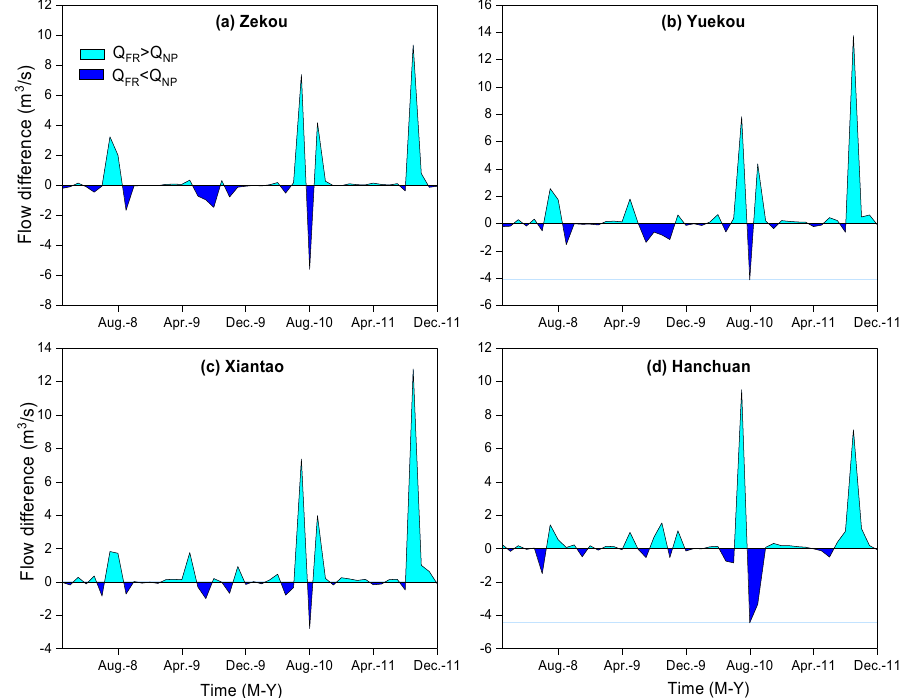
Figure 6. Monthly average flow differences at the gauging stations along the lower Han River between the natural processes and the processes under the flow regulation of the TGR from 2008 to 2011. The Q FR and Q NP denote the flow discharge at the gauging stations with and without the influence of TGR operation.